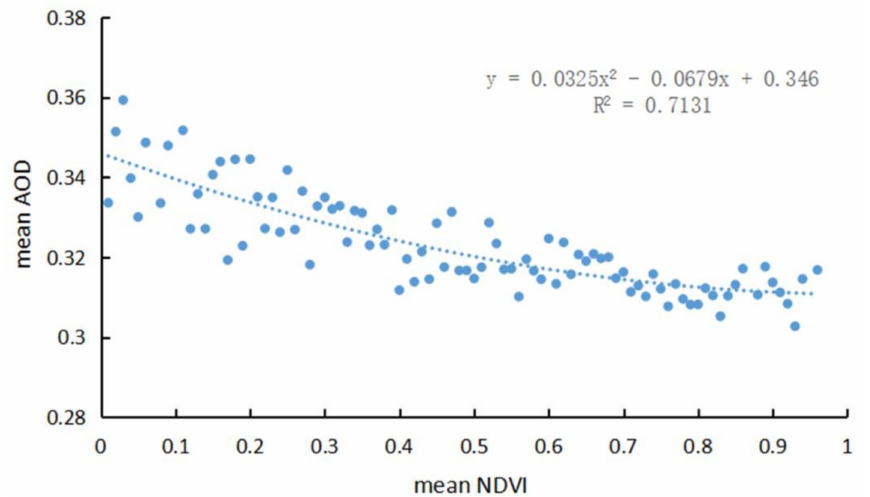
Figure A1. Relationship between NDVI (Normalized Difference Vegetation Index) and associated AOD (Aerosol Optical Depth) values in the NDVI range of 0 to 1.